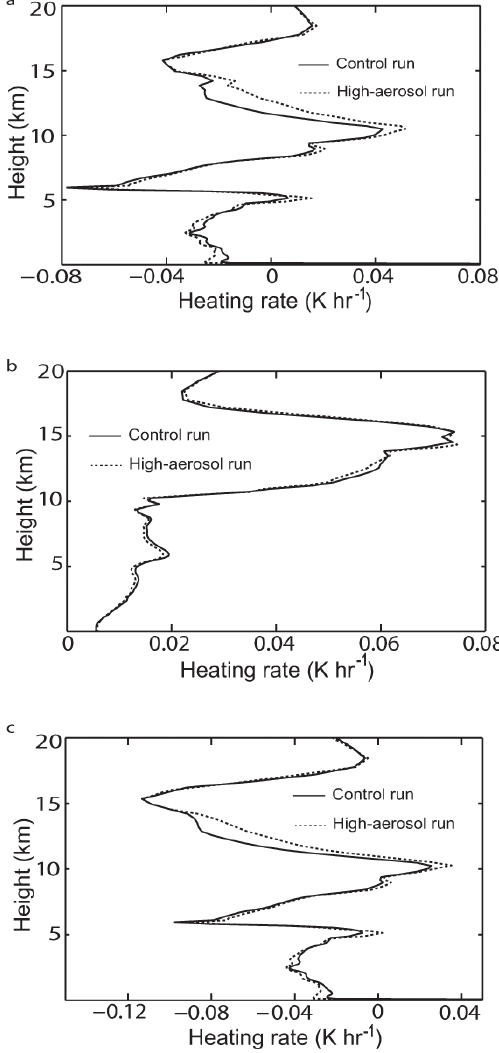
Fig. 11. Vertical distributions of the time- and domain-averaged (a) net radiative, (b) shortwave radiative, and (c) longwave radia- tive heating